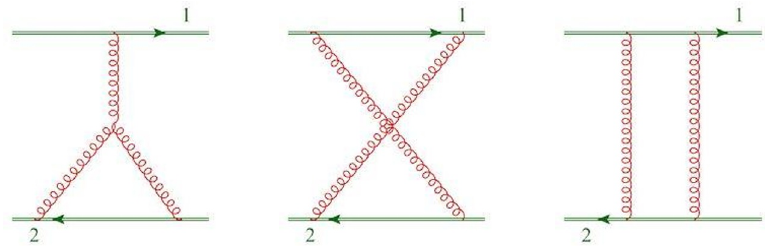
Figure 2. The (cid:12)rst two diagrams contribute to W 2 , while the third diagram, which becomes disconnected by cutting the two Wilson lines, does